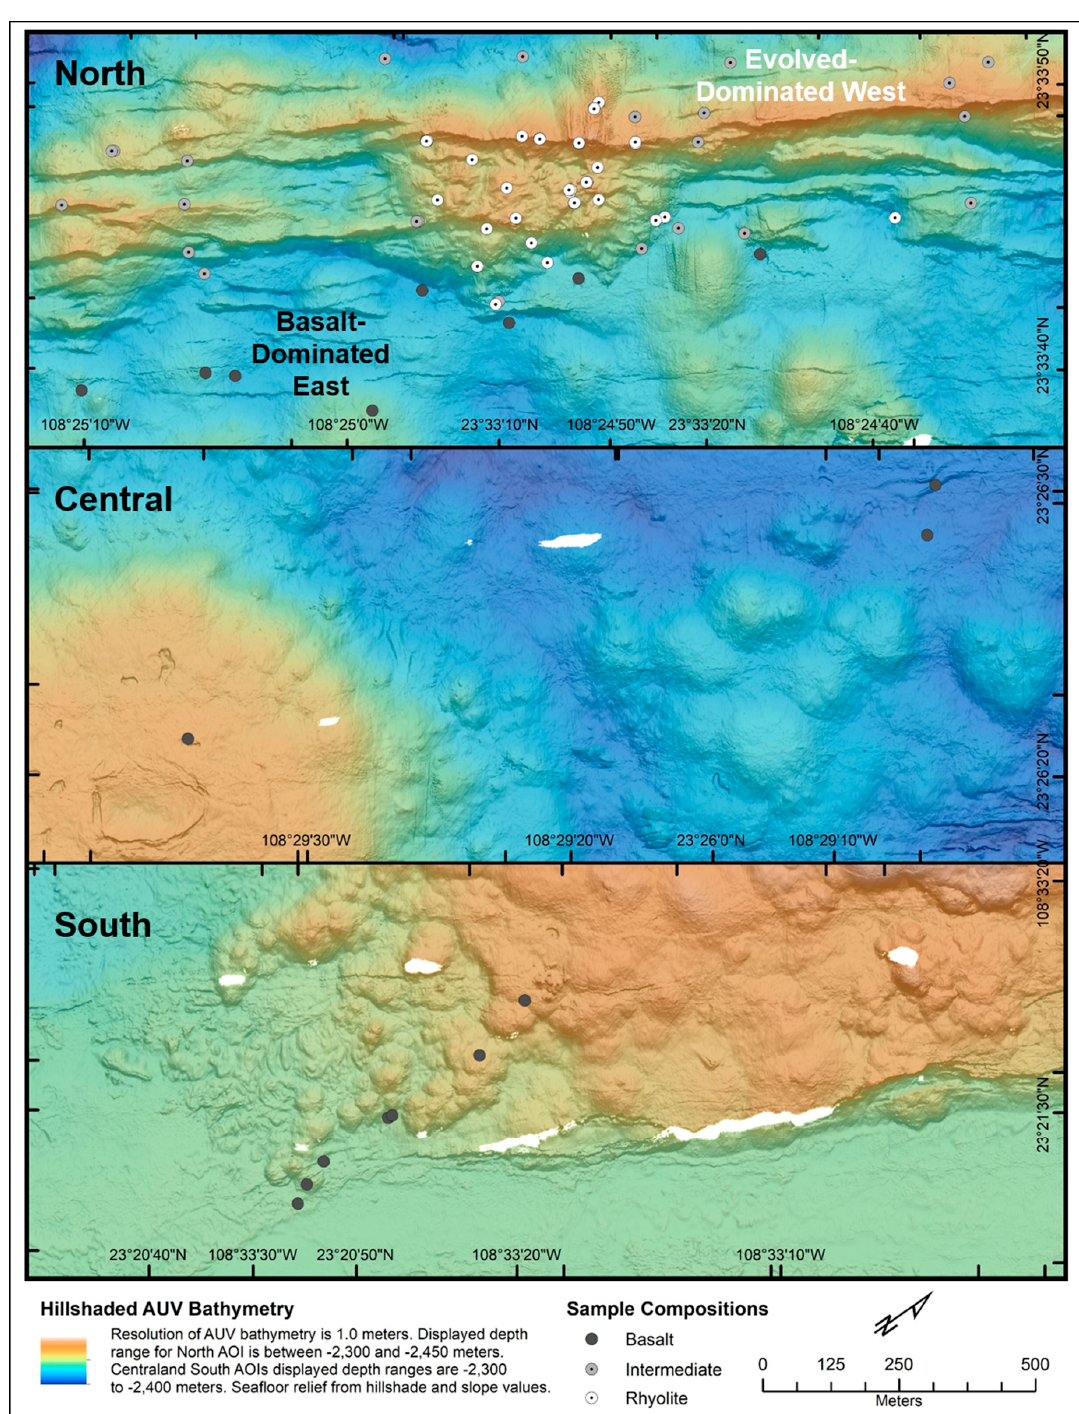
Figure 3. Examples of the distinct geomorphic provinces at the Alarcon Rise from Figure 1. Samples with basalts on mounds on the east and rhyolites cropping out on the ridge to the west were collected in the north AOI (top panel), which shows the rhyolitic dome and part of a 9 km-long ridge. The central AOI is dominated by a 700 m-diameter volcanic cone in the lower left of the map area shown (middle panel). The south AOI is dominated by a hummocky lava shield to the east side of the spreading axis (bottom panel).